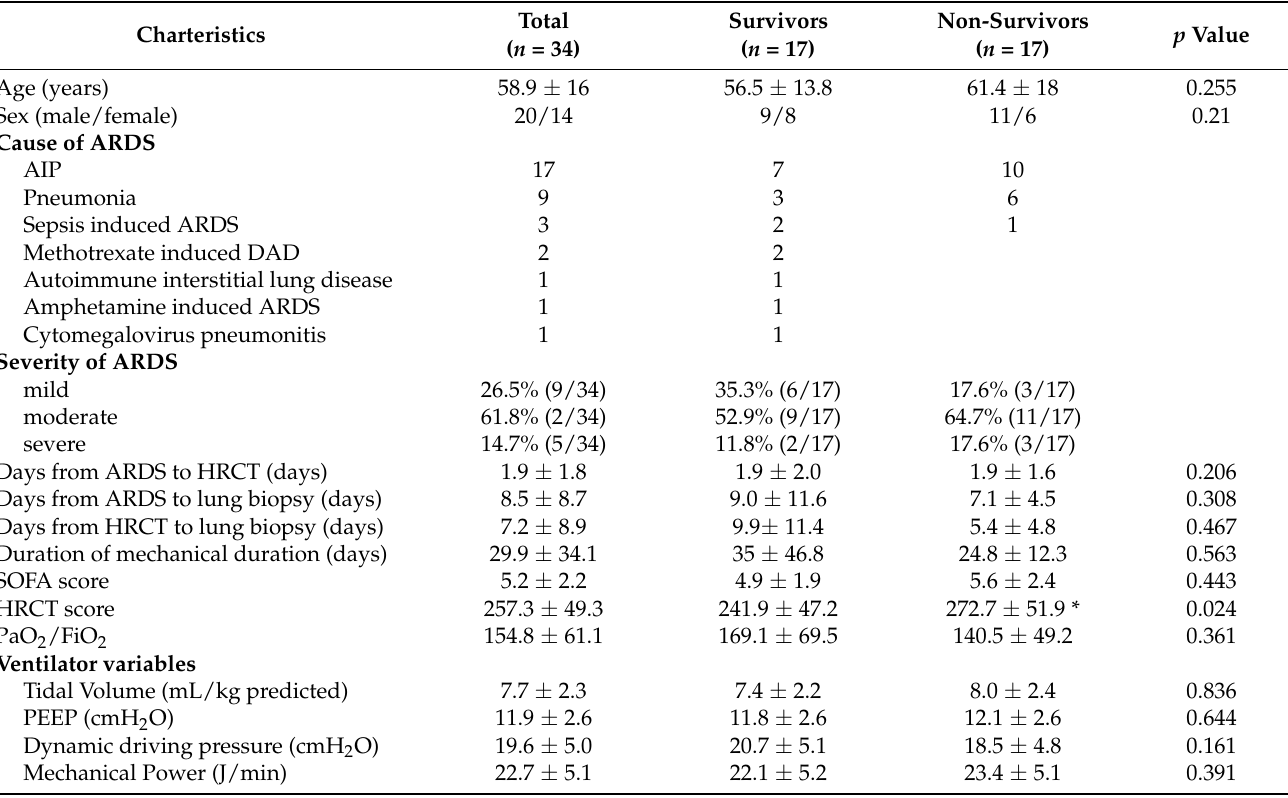
Table 1. Clinical Characteristics of ARDS Patients with DAD.